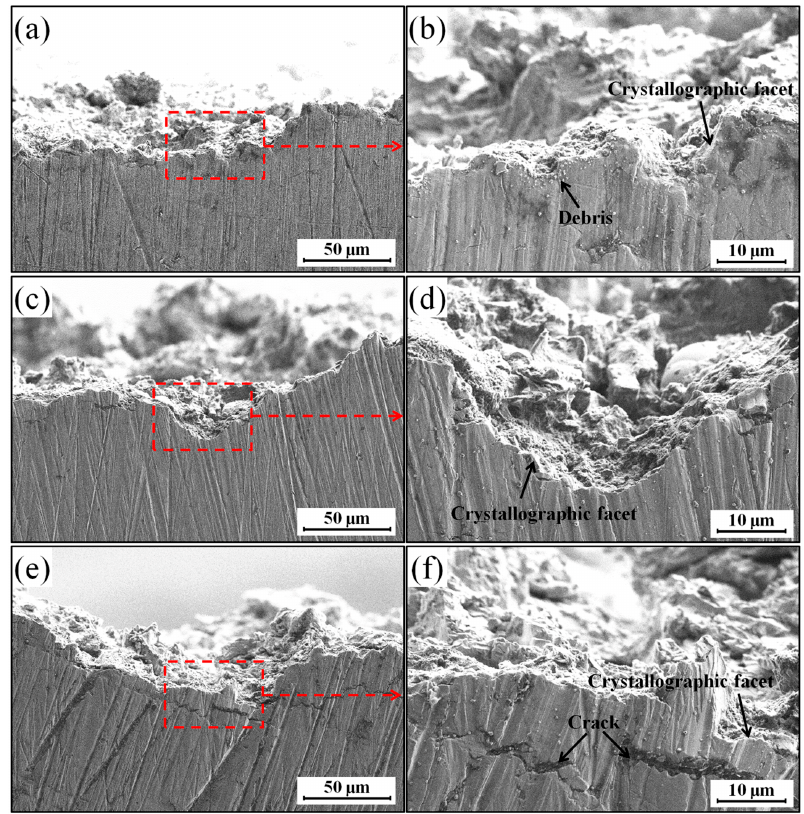
Figure 8. SEM morphology of longitudinal section of the tensile specimen of the coating samples: ( a ) HSC0, ( b ) Enlarged image of ( a ), ( c ) HSC04, ( d ) Enlarged image of ( c ), ( e ) HSC08, ( f ) Enlarged image of ( e ).